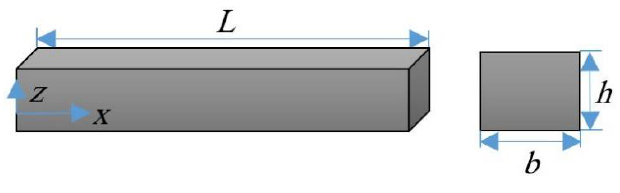
Figure 1. Geometry of the nanobeam.